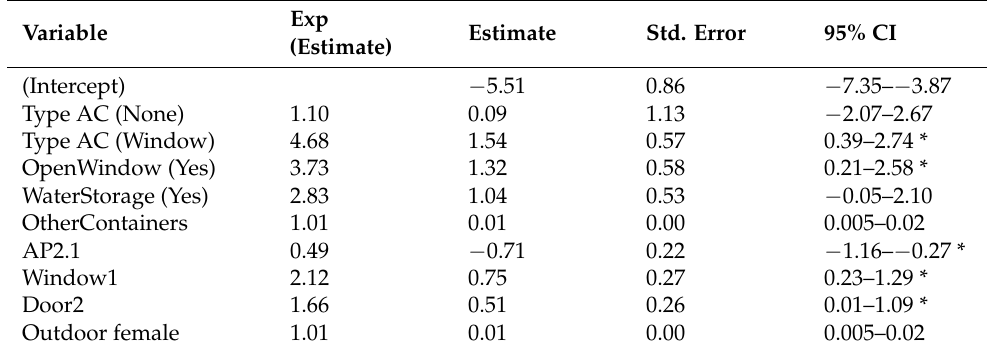
Table 6. Main effects statistics for the best fit generalized linear model (NB2) for indoor female Ae. aegypti abundance in South Texas.